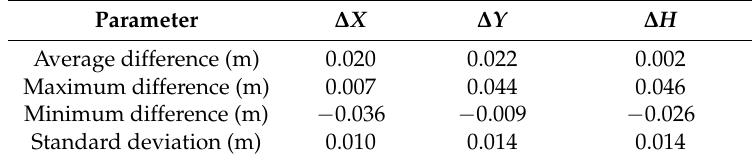
Table 4. Comparison of coordinates of points determined using static GNSS and RTK GNSS.